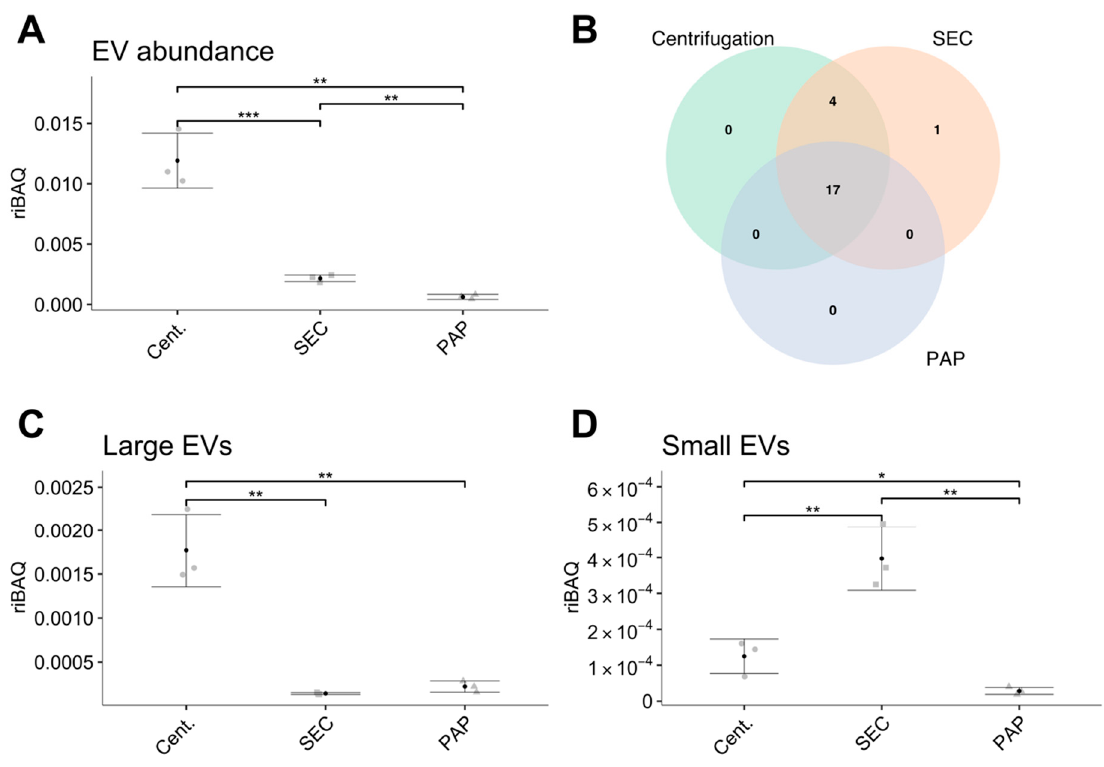
Figure 4. Differences in the abundance and amount of extracellular vesicle (EV) specific proteins in isolates obtained by high-speed centrifugation (Cent.), size exclusion chromatography (SEC), and peptide affinity precipitation (PAP). ( A ) The difference in abundance of EV specific proteins. ( B ) Venn diagram showing the number of identified EV specific proteins per isolation method. ( C – D ) Comparison of relative abundances of EV subtypes divided into large EVs ( C ) and small EVs ( D ). Error bars: Mean ± SD. Significance levels: * ( p -value < 0.05), ** ( p -value < 0.01), and *** ( p -value < 0.001).